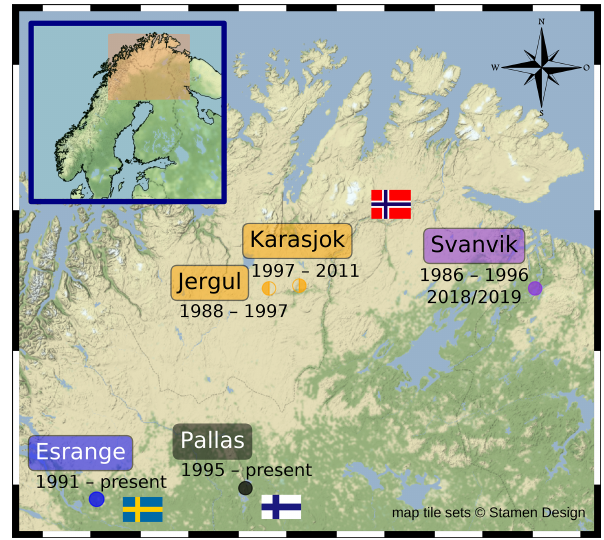
Figure 1. Subarctic Europe north of 67.5 ◦ N, here referred to as northern Fennoscandia. Locations of past and present ozone obser- vation sites used in this study. For more details, see Table 1. The introduced color coding for the monitoring sites is used